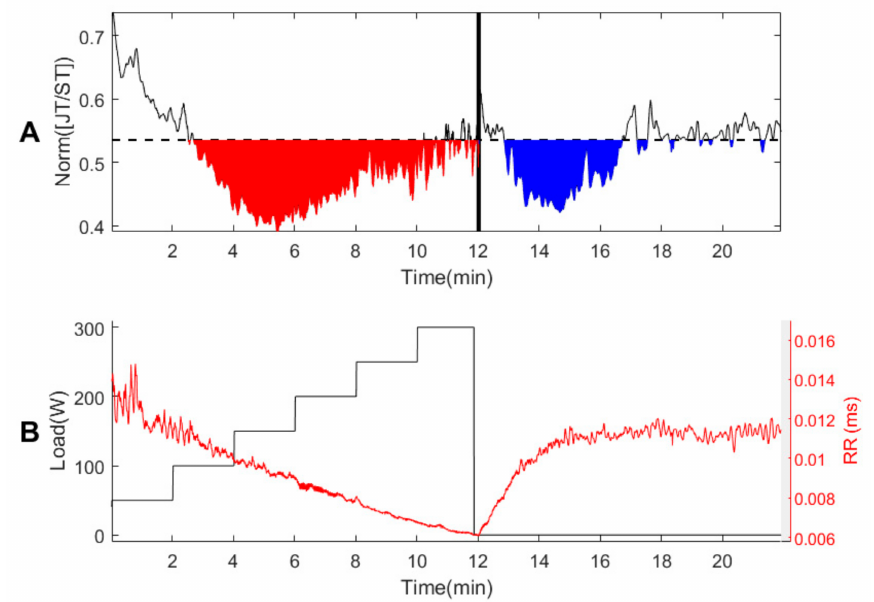
Figure 2. The dynamics of the JT/ST relationship during the load and the recovery processes for person #1 The x -axis in parts ( A , B ) represents the time (measured in minutes) from the beginning of the cycle ergometry exercise. The left y-axis in part ( B ) represents the power of the load in Watts. The right y-axis in part ( B ) represents the variation of the RR interval in ms. The algebraic JT/ST relationship is represented by the thin dashed black line in part A. The thick black solid vertical line in part A marks the end of the